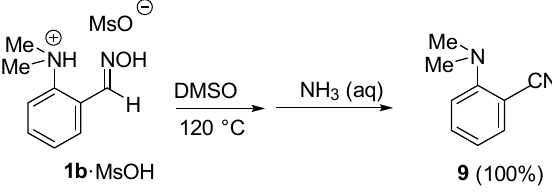
Figure 5. Comparison of reaction profiles for E - 1a · H + → 4a (red) and E - 1b · H + → 4b (blue) via “acidic” path C.